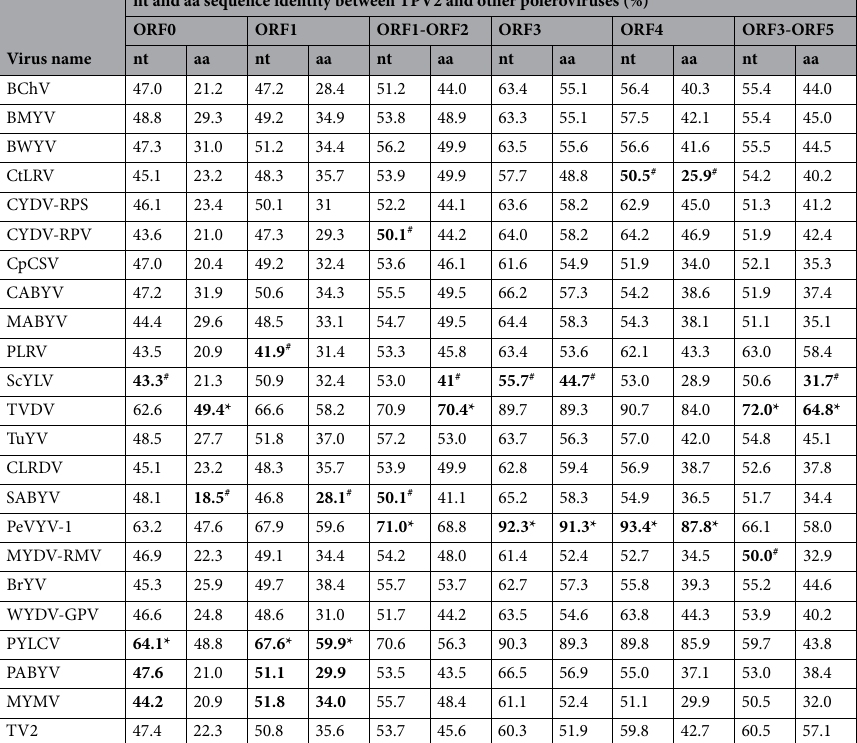
Table 5. Nucleotide and amino acid sequence comparisons of different ORFs of TPV2 with those of other poleroviruses. The bold in the table represent the highest and lowest identities individuals. *The virus shares the highest sequence identity with TPV2; # the virus shares the lowest sequence identity with TPV2.